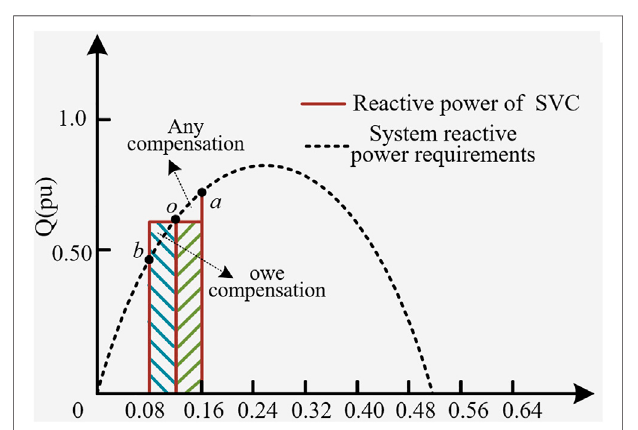
FIGURE 2 | Schematic diagram of SVC under compensation and over compensation.